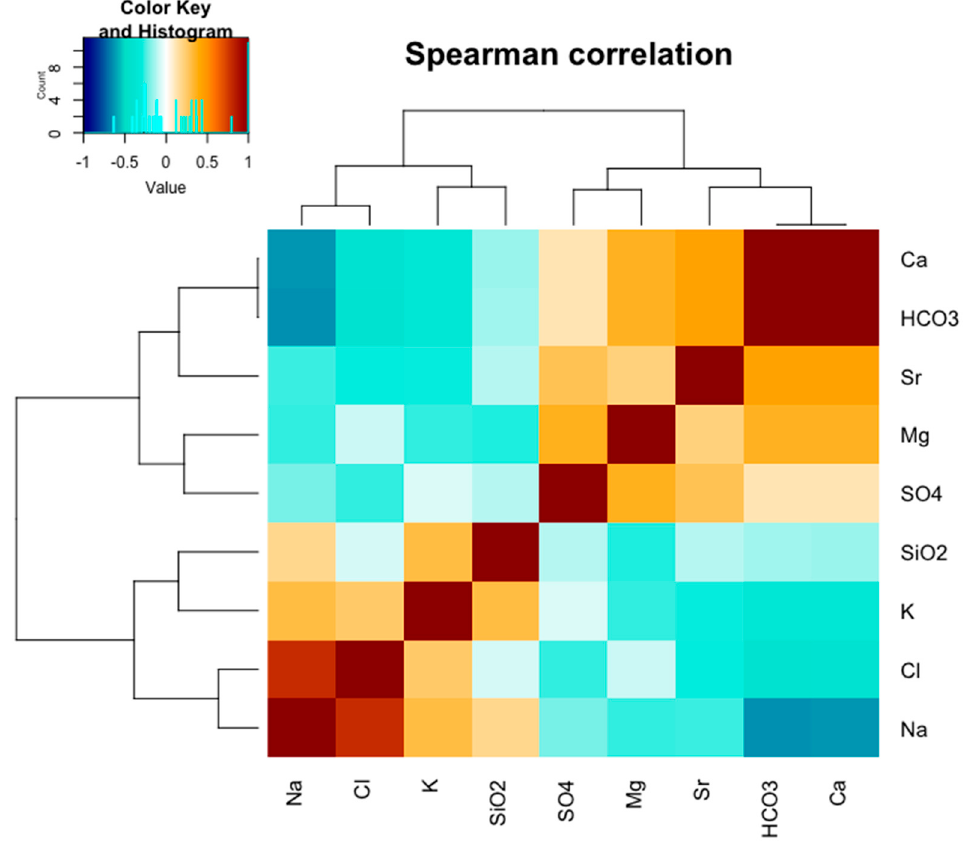
Figure 4. Heat map for perturbation-subtraction values: red colors indicate positive correlations, whereas blue colors indicate negative correlations; the color intensity shows the magnitude of the Spearman correlation coefficient [33].